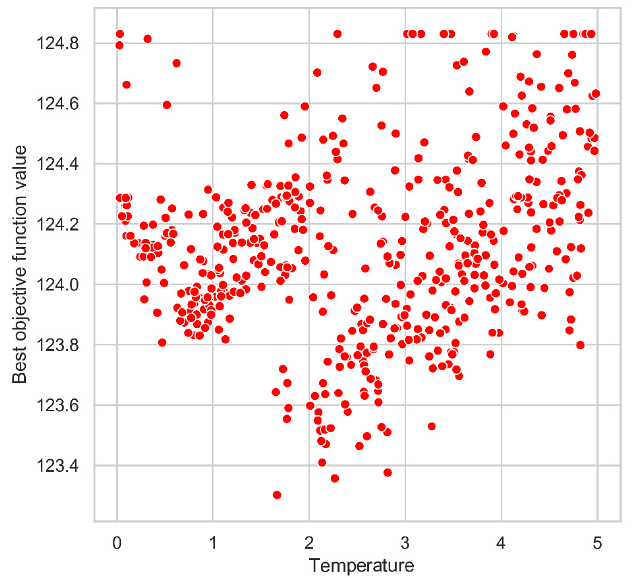
Figure 9. A dot plot diagram of the probabilistic dependence of the resultant objective function values 𝜑(𝑥̅) collected using the very fast simulated annealing method upon the temperature 𝑇 0 .